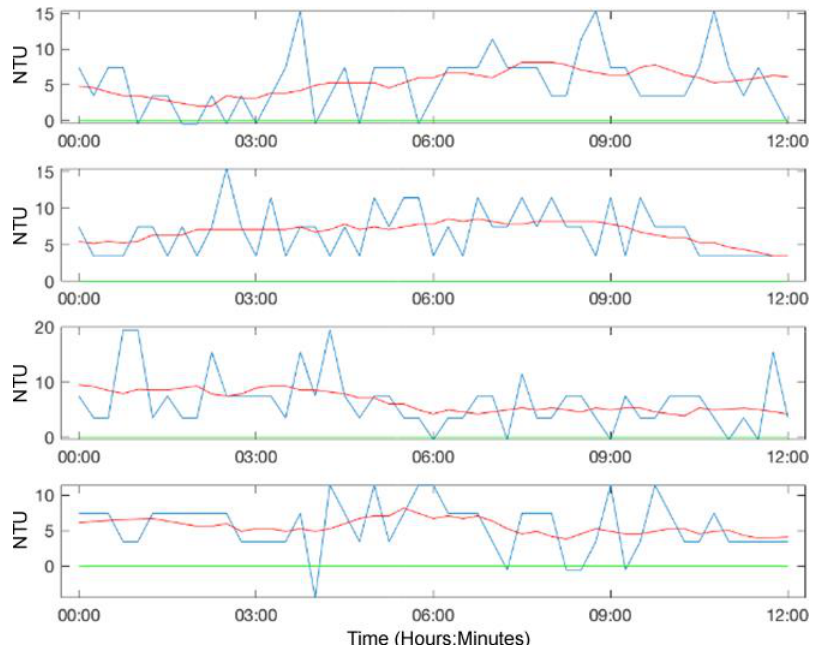
Figure 12. Calibrated turbidity data from the Wyaralong Dam deployment. The plot shows 48 hours of turbidity readings taken over four consecutive night time periods of a twelve-hour duration. The blue line displays the raw turbidities, while the red line is a running average of the five previous and post